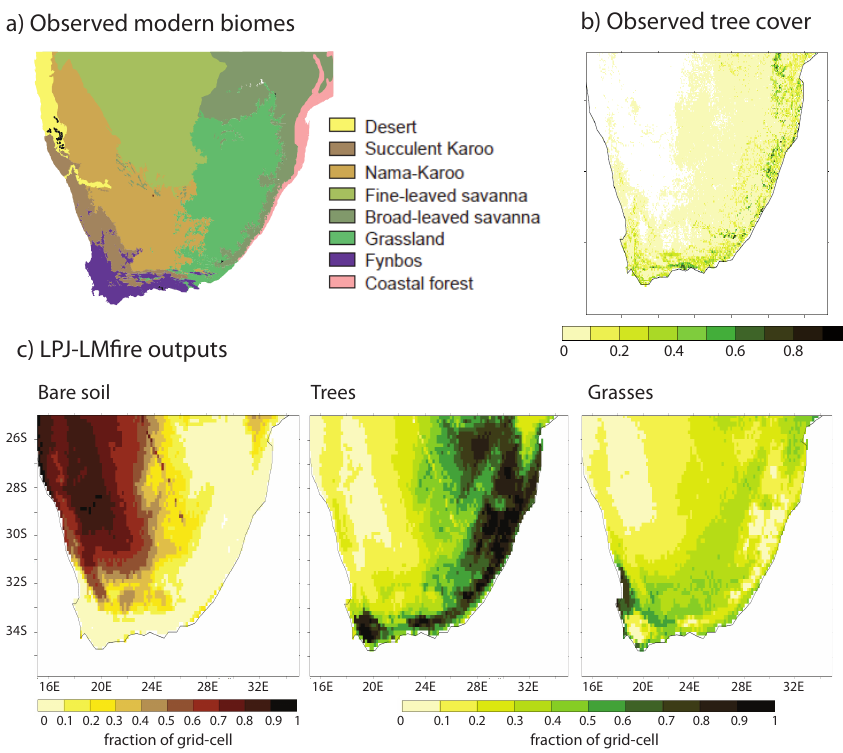
Figure 4. (a) Modern biomes of southern Africa (Scholes, 1997; Mucina et al., 2007). (b) Observed tree cover from remote sensing data, average over years 2001–2010 (MODIS database, Townsend et al., 2011). Grid cells with fractions < 1% are in white. (c) Vegetation cover (bare soil, trees and grass fractions) simulated with LPJ-LMfire forced off-line by the outputs of a present-day IPSL_CM5A simulation downscaled to 0.16 ◦